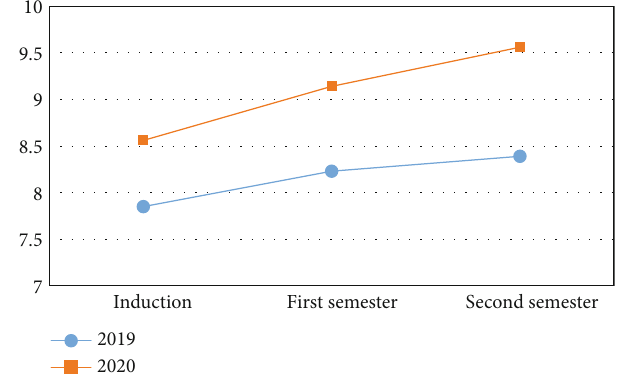
Figure 3: Comparison chart of students ’ aerobic performance and employers ’